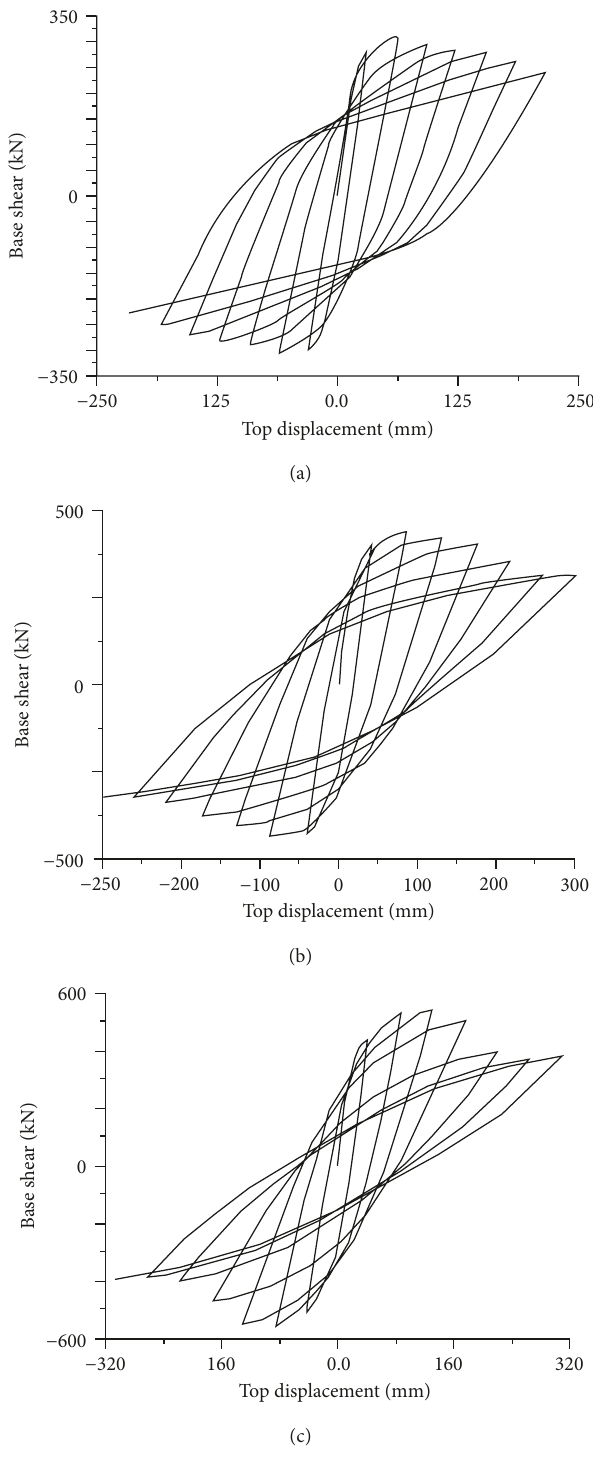
Figure 15: Hysteretic curves of bottom shear force versus top displacement: (a) WALL1; (b) WALL2; (c)